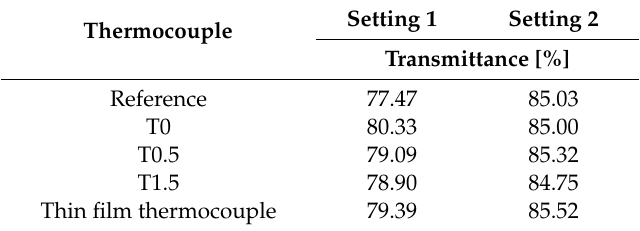
Table 4. Results of the transmission results in dependence of the used